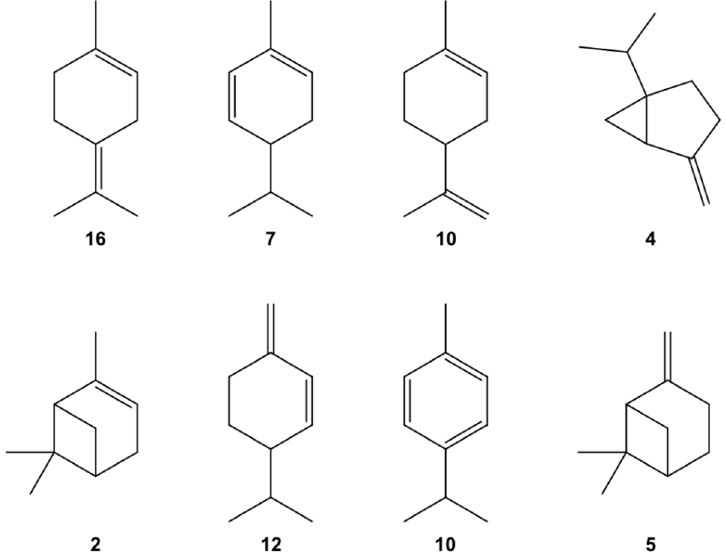
Figure 1. Structure of major compounds identified in an EO obtained from C. schweinfurthii oleoresin collected in Gabon: terpinolene (no. 16), α -phellandrene (no. 7), limonene (no. 11), sabinene (no. 4),